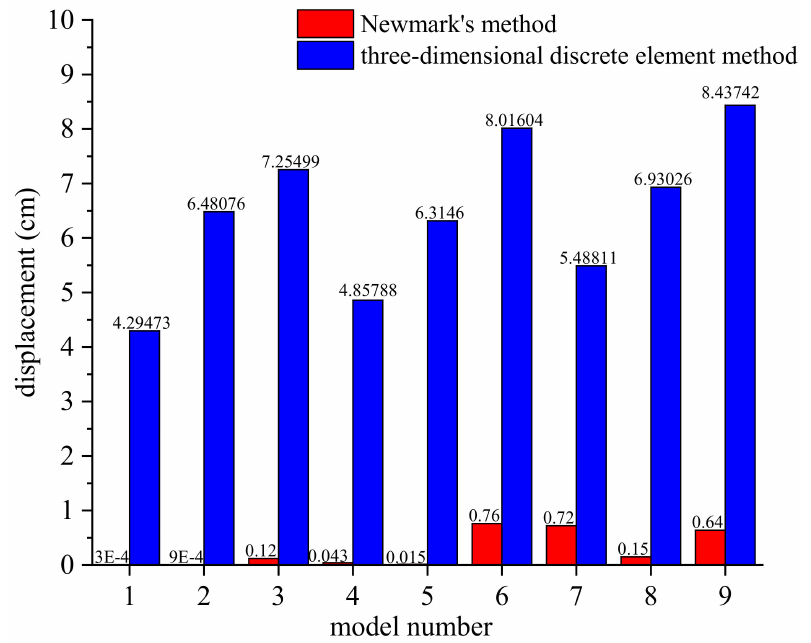
Figure 16. Comparison of the permanent displacements of point D5 (in the Y -direction) under the action of a natural seismic wave as calculated using Newmark’s method and dynamic 3D discrete- element